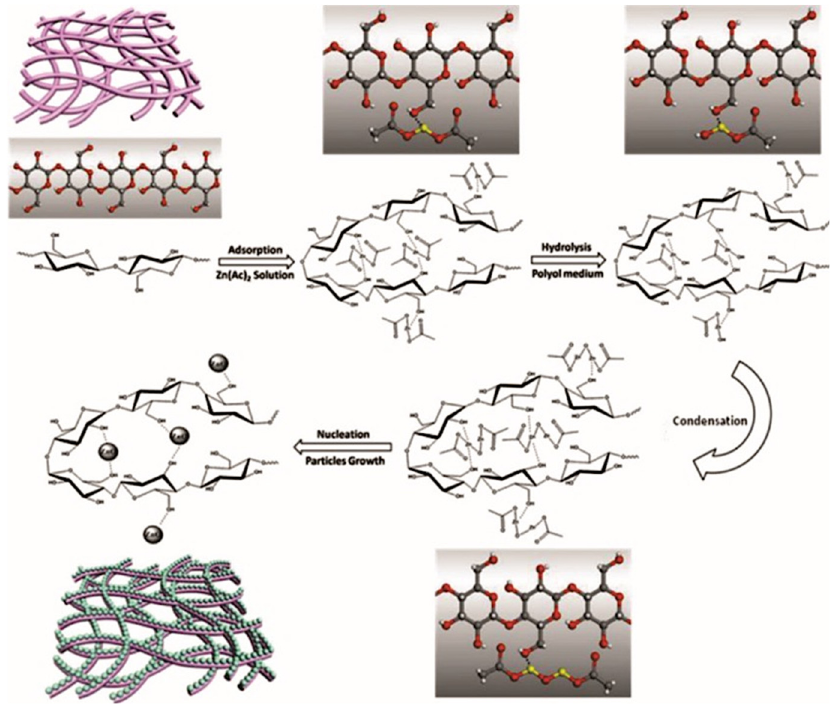
Figure 7. The schematic illustration of the formation of the ZnO nanoparticles impregnated into the BC [ 167 ] . Copyright 2013, with permission from Elsevier Ltd. BC [167]. Copyright 2013, with permission from Elsevier